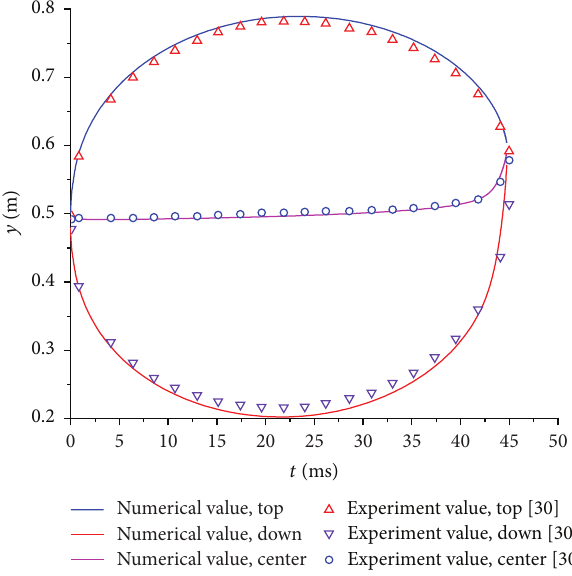
Figure 7: Comparison curves of bubble upper surface, lower surface, and center position along with